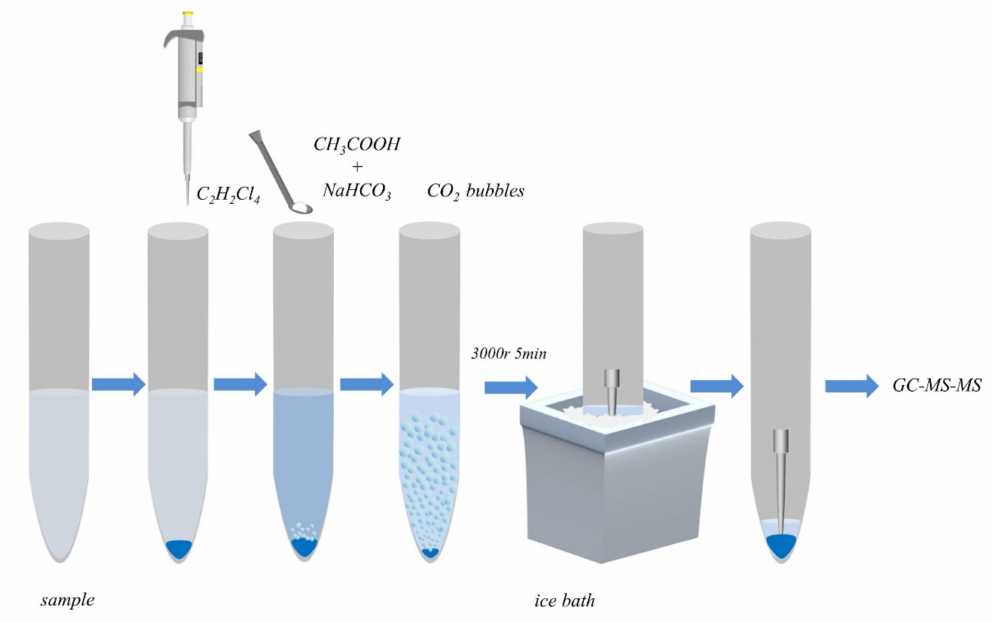
Figure 6. Schematic diagram of the EA-DLLME-SAP